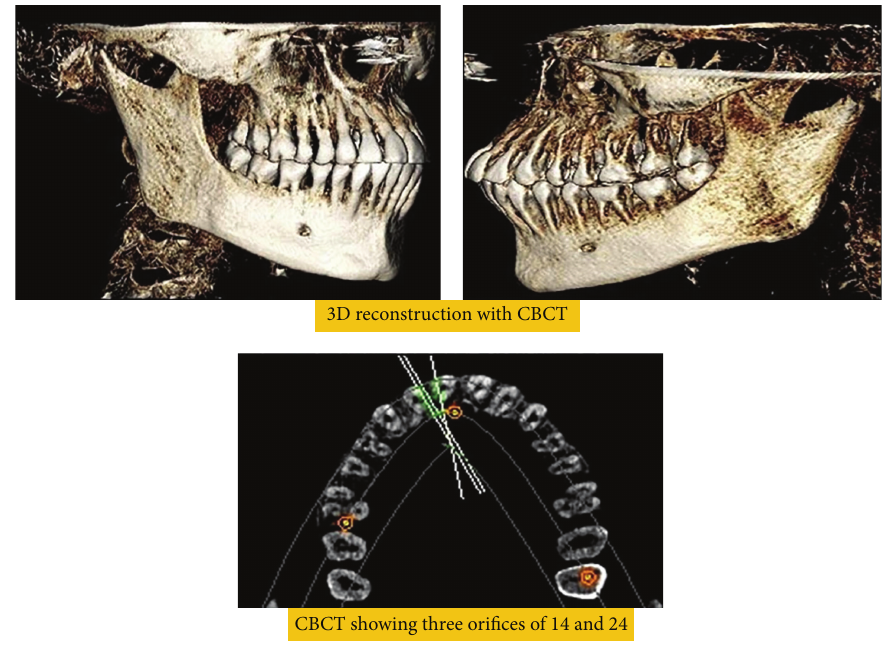
CBCT showing three orifices of 14 and 24 Figure 2: CBCT images of 14 and